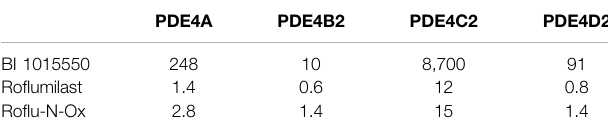
TABLE 1 | Inhibition of human recombinant PDE4 subtypes by BI 1015550 in comparison to ro fl umilast and its active metabolite Ro fl u-N-Ox. IC 50 values (nmol/L) are given as means from 3 (4A, 4C2) and 4 (4B2 and 4D2 active site fragments) independent experiments. Cell extracts containing the active site fragments mediated the conversion of 10 µL [ 3 H]cAMP (0.05 µCi in H 2 O) to AMPresultinginthebindingofthisradiolabeledmoleculetotheyttrium silicate SPA beads and the subsequent generation of scintillation events determined using a Wallac Microbeta counter. AMP, adenosine monophosphate; IC 50 , inhibitory concentration (nM) for half-maximal inhibition; PDE, phosphodiesterase; SPA, scintillation proximity assay.